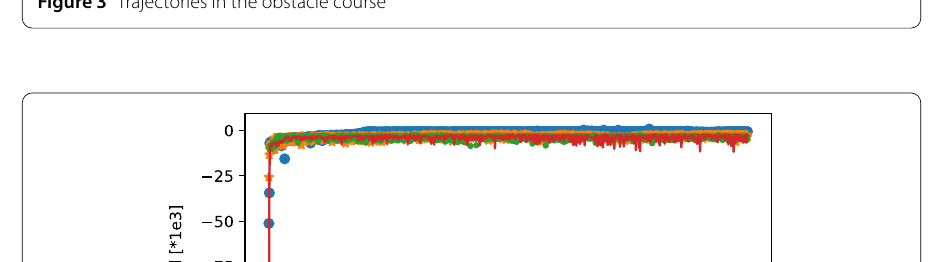
Figure 3 Trajectories in the obstacle course